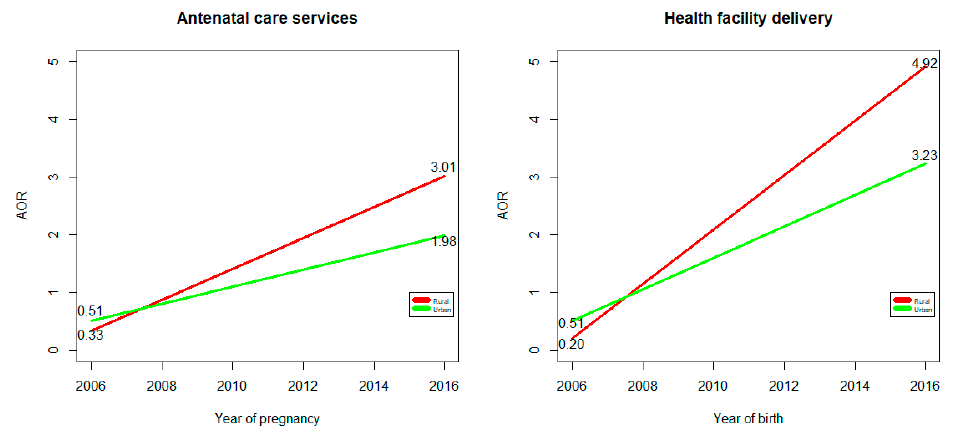
Figure 1. The changes in odds of uptake of skilled maternal healthcare service utilization (antenatal care or health facility delivery) among positive deviant women in urban and rural areas in Ethiopia between 2006 and 2016. Vertical axis = adjusted odds ratio (AOR); horizontal axis = survey periods.